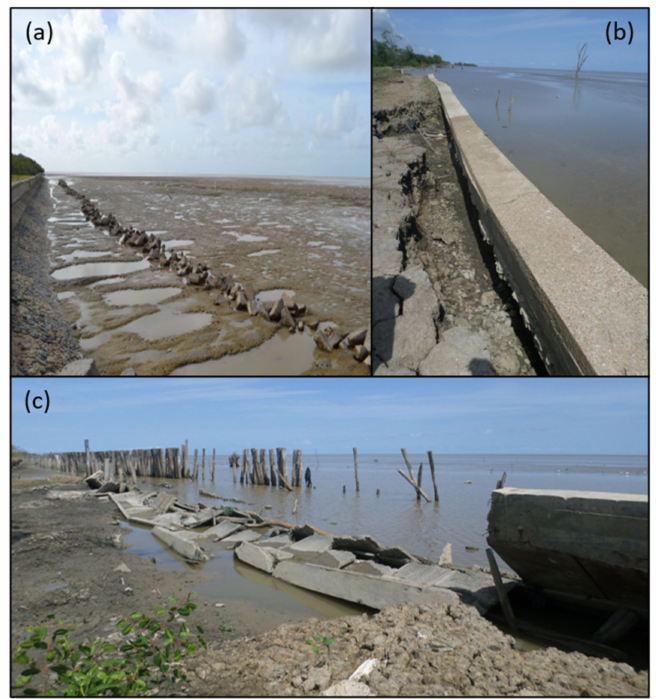
Figure 8. Photographs of damaged and ineffective concrete dykes in Guyana in May, 2012 ( a ), and Suriname in October 2015 ( b , c ). The Guyana dyke is fronted by a deepened, concave foreshore erosion profile caused by wave reflection and offshore dispersal of mud. The poorly designed Suriname dykes were built just two years before the photo was taken at Weg Naar Zee, near Paramaribo, and were not subsequently